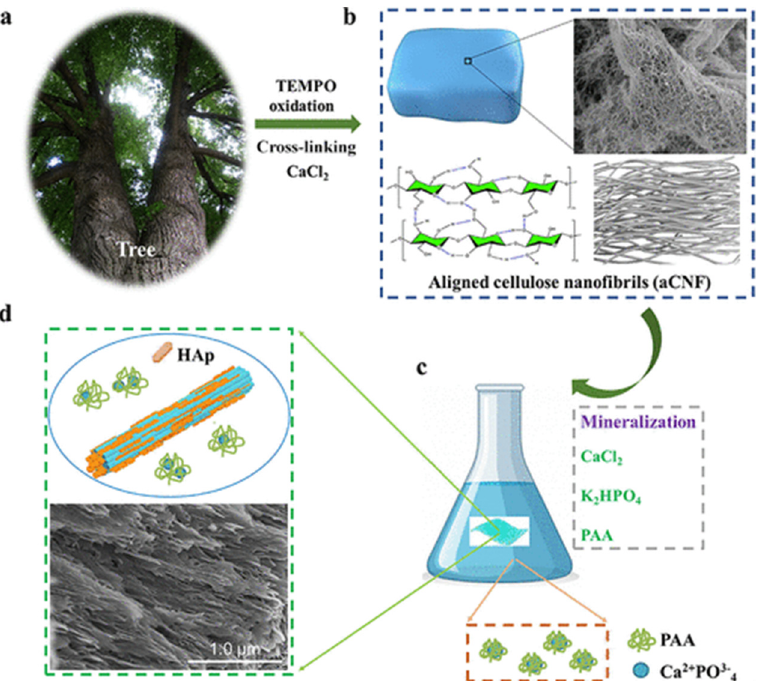
Figure 12. Schematic diagram of m-aCNF composite: ( a ) a tree; ( b ) aCNF and its structure; ( c ) Metallogenic processes; ( d ) The obtained m-aCNF material and its scanning electron microscope photographs show the oriented mineralized structure. Data reproduced from ref. [126].